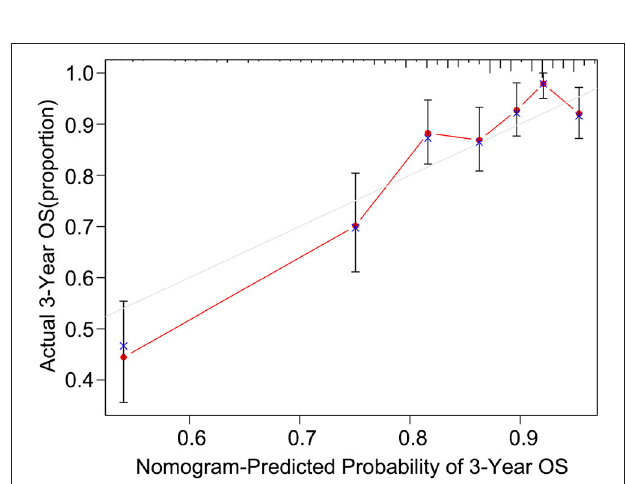
FIGURE 4 | The calibration curve of the nomogram for predicting the 3-year OS of the training